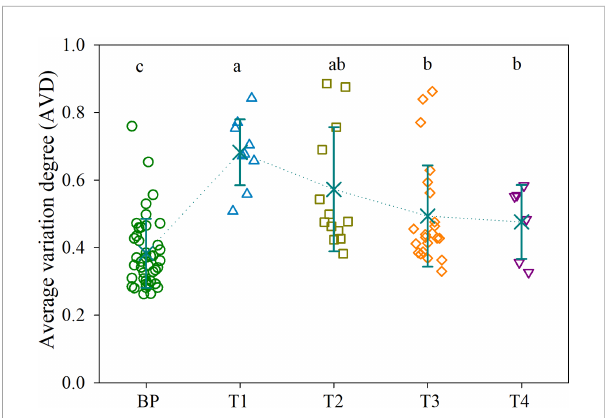
FIGURE 2 Average variation degree (AVD) for the bacterial communities in BP and along the four CRC stages. Different lowercase letters indicate signi fi cant differences among groups using one-way analysis of variance (ANOVA) with signi fi cant level of P < 0.05. Refer to Figure 1 for